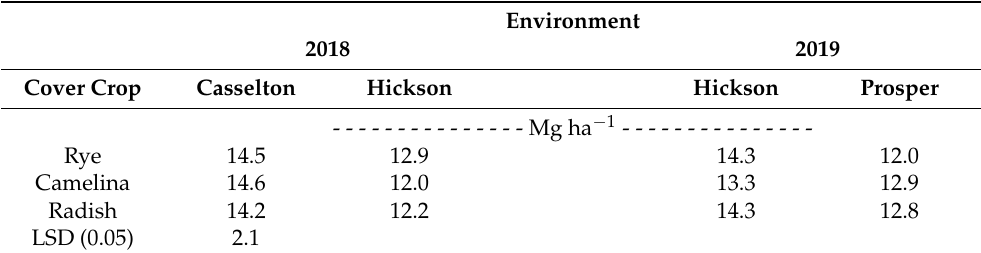
Table 6. Mean maize grain yield for three cover crops at four environments averaged across two sowing dates at Casselton, Hickson, and Prosper, ND, USA, in 2018 and 2019.